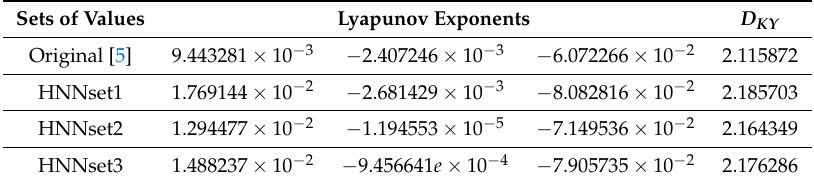
Table 3. Lyapunov exponents and Kaplan–Yorke dimension D KY associated to each set of values from Table